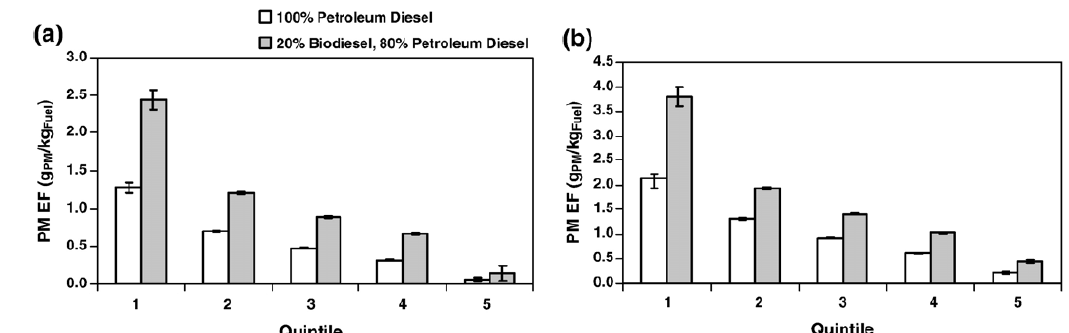
Figure 12. Quintile distributions of particulate matter (PM) emission factors (EFs) for school buses with hot-stabilized and cold-start engine conditions. Panel (a) represents results obtained in hot engine conditions; panel (b) represents cold-start conditions only [13].